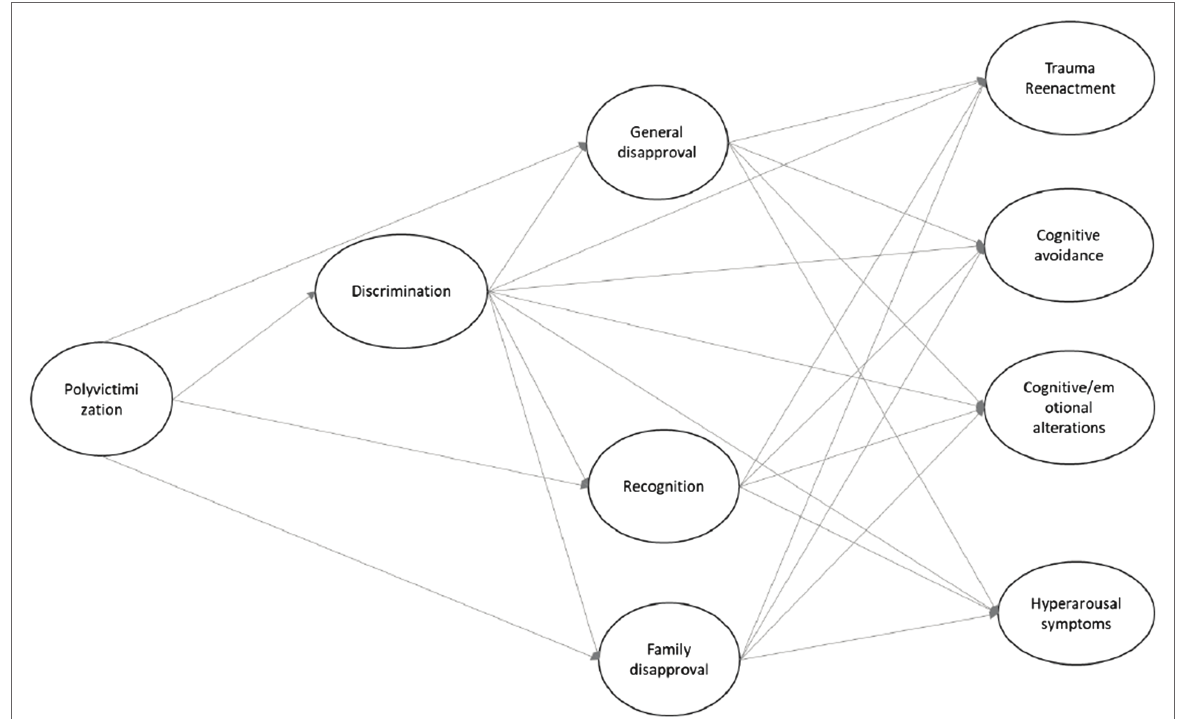
FIGURE 1 | Theoretical integrated model depicting observed paths among study